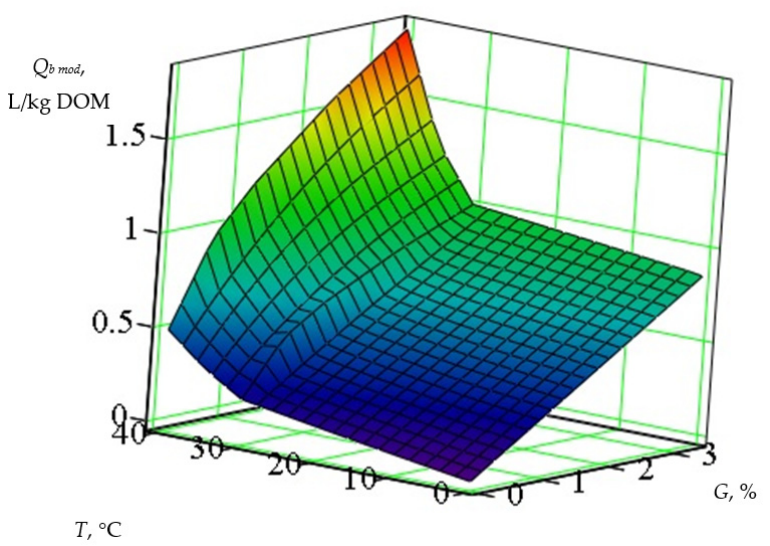
Figure 5. Response surface describing the simulated biogas yield for gradual loading of the digester during fermentation of cattle manure with the addition of crude glycerine.